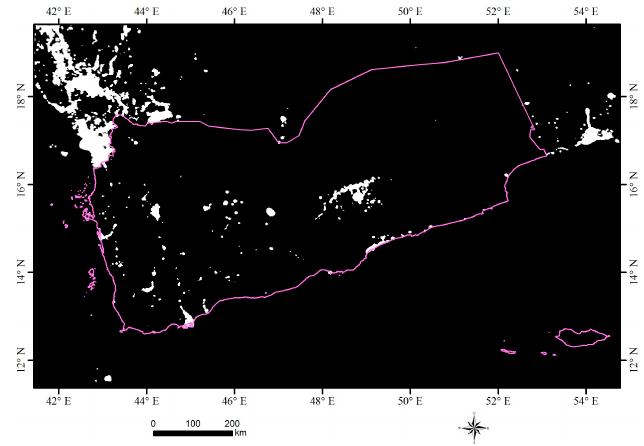
Figure 6. The Yemen city mask based on DMSP-OLS nighttime light images.